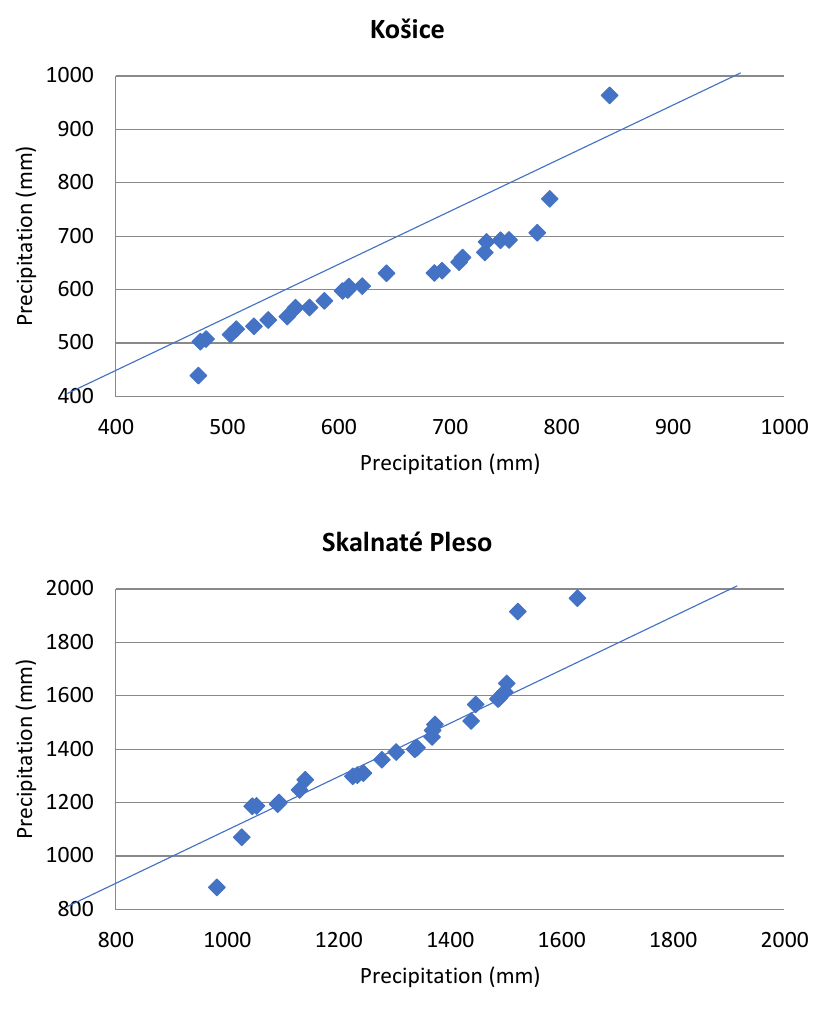
Figure 3. Precipitation of Košice and Skalnaté Pleso stations by the Sen trend test.